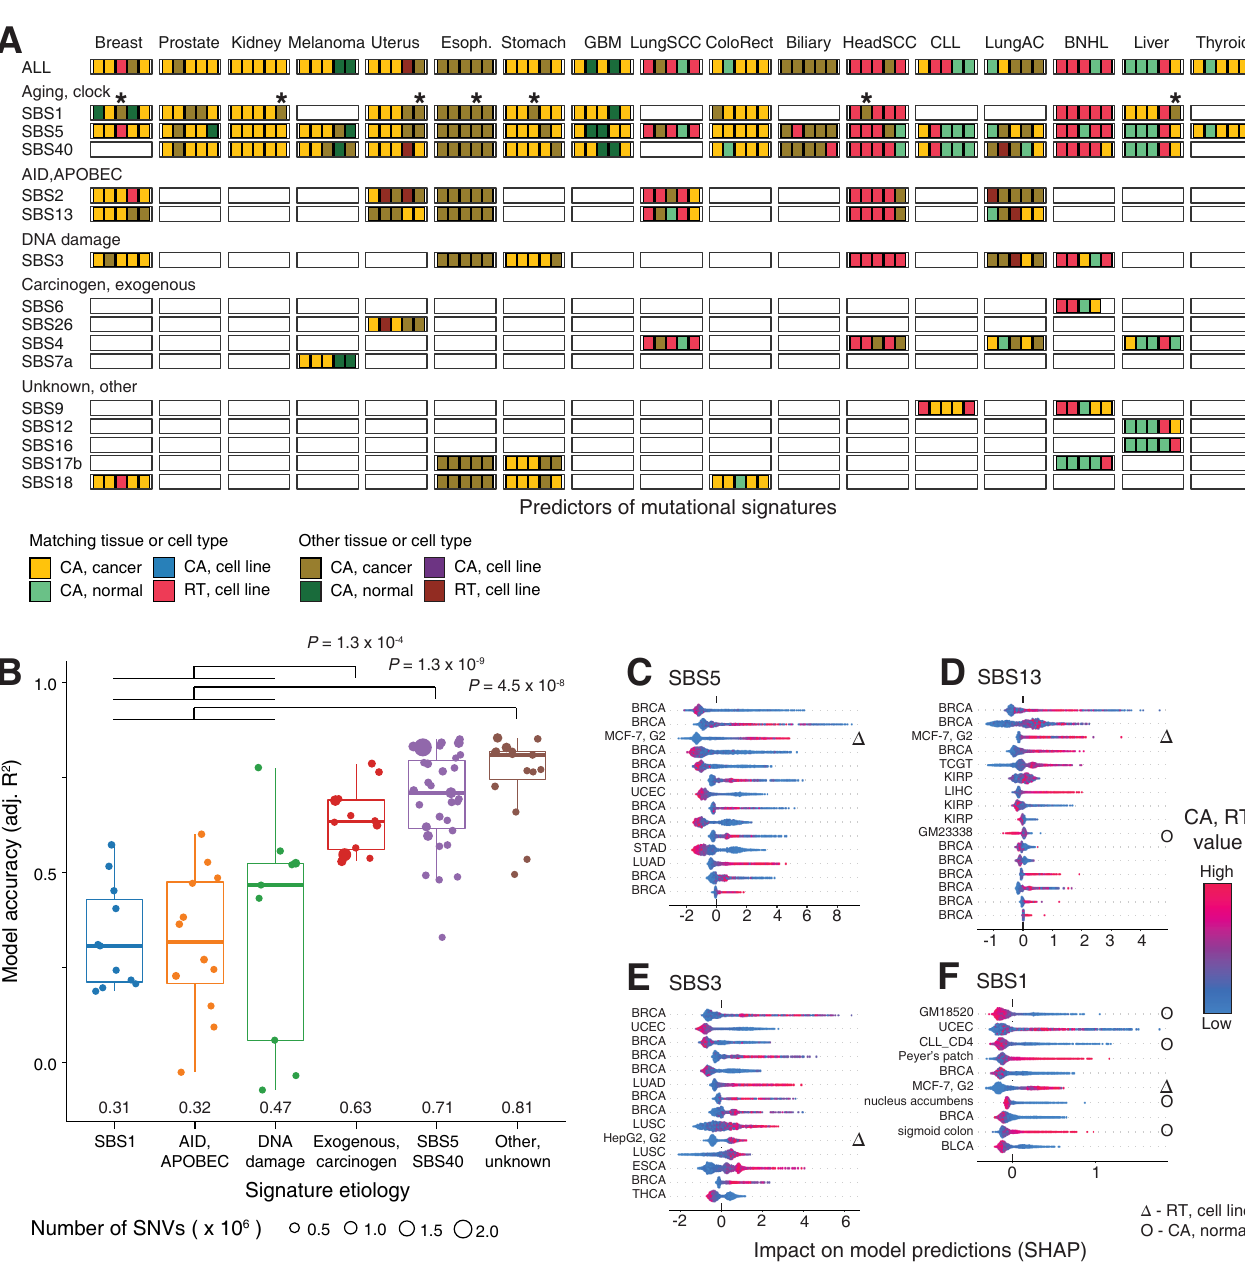
Fig 4. Associations of mutational signatures with chromatin accessibility and replication timing. A. Top predictors of megabase-scale mutation burden of single base substitution (SBS) signatures (top five predictors; P < 0.001, permutation test). Colors indicate the predictor type (CA, RT) and its relationship to the cancer type where mutagenesis is predicted (matching site/tissue or other). Brighter colors indicate the predictors where the epigenomic profile (CA or RT) matches the cancer type of the mutation profile. Asterisks indicate CA profiles of CD4-positive T-cells as predictors of SBS1 mutations. All significant predictors are shown in S7B Fig. Prediction accuracy of megabase-scale burden of SBS signatures using CA and RT profiles. Signatures of carcinogens, unknown origin, and aging are more accurately predicted by CA and RT profiles than endogenous signatures. P -values are computed using F-tests with adjustment for genome-wide signature burden. Median accuracy values are printed. C-F . SHAP scores of significant predictors of selected mutational signatures in breast cancer. SHAP scores show the impact of the predictor ( i . e ., CA or RT profile) on the predictions of SBS burden (X-axis) and the corresponding predictor values (color gradient). Symbols indicate RT profiles (triangles) and CA profiles of normal tissues (circles). SHAP scores for all significant SBS predictors for breast cancer are shown in S8 Fig .